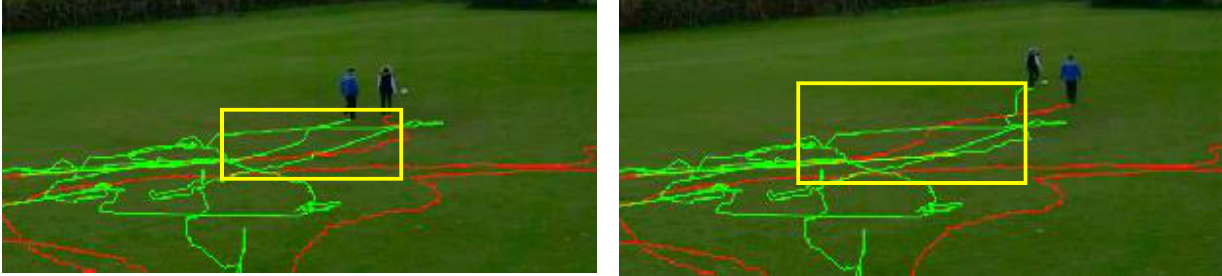
Figure 12. An example for the “retroactive” assignment correction: ( a ) the last trajectory parts (yellow box) are assigned wrongly; ( b ) the assignment has been corrected a few time steps later.